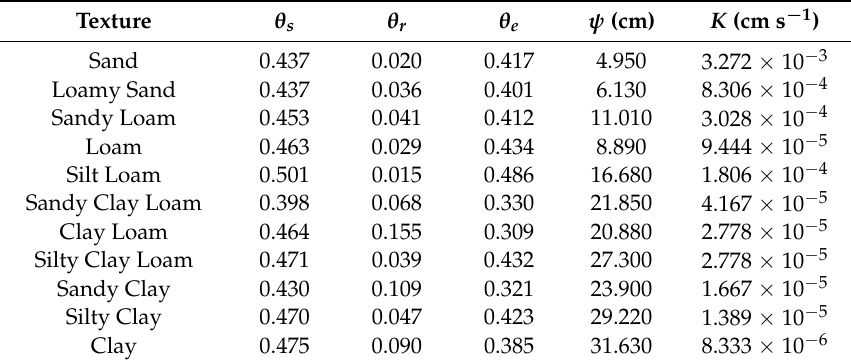
Table 2. Green-Ampt infiltration parameters for various standard and tilled* soil